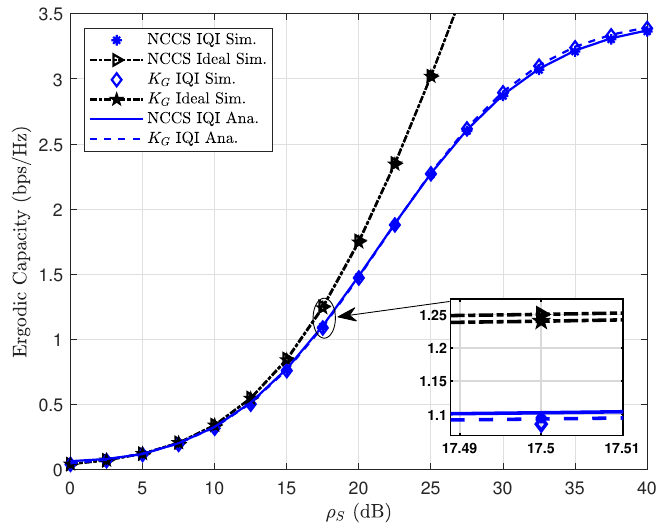
Figure 8. The ergodic capacity vs. ρ S (dB) for RIS-DH case with N = 2.